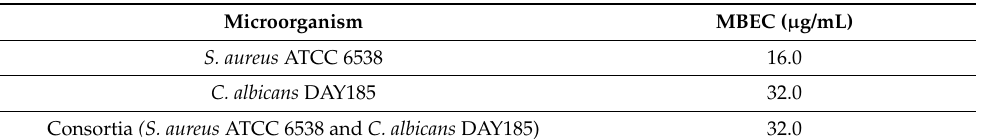
Table 6. MBEC for the synthesized Mo-capped